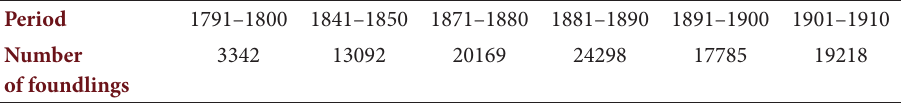
Table 8. Dynamics in the number of infants placed in foundling homes in Moscow and St. Peters- burg,